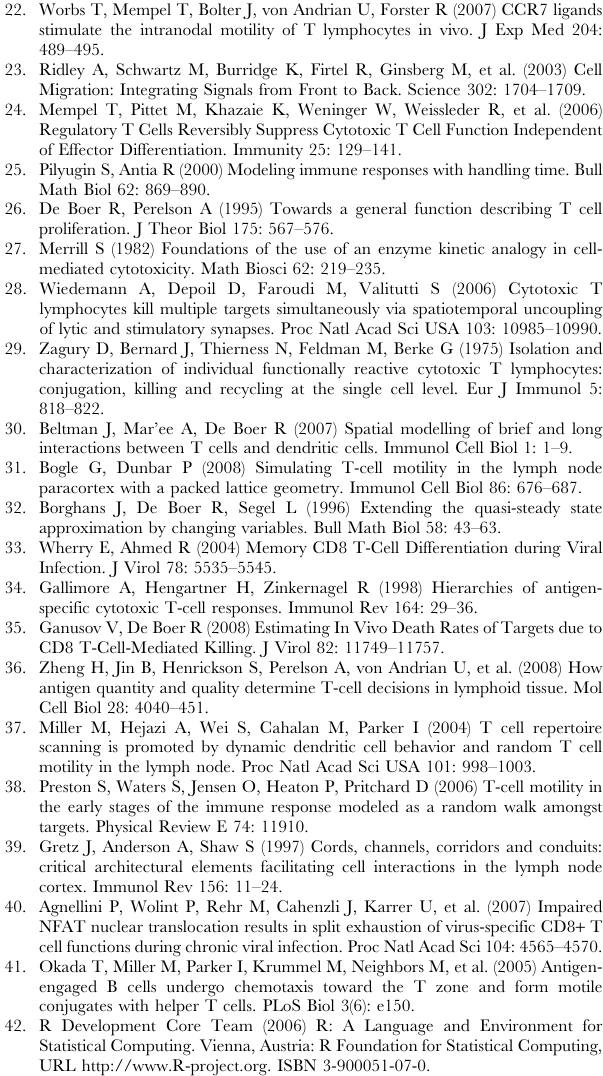
Figure S4 Estimates for k given different probabilities of recognition of CTL for targets. The killing duration and the CTL velocity were kept constant ( v h , 10.8 m m/min, t D = 15 min). Each dot represents the estimate for one simulation follwed over a time period of 300 min using the revised estimation method based on the proportion of target cells killed. Blue squares represent the mean values per probability of recognition. Found at: doi:10.1371/journal.pcbi.1000466.s004 (0.11 MB TIF) Video S1 Movement of simulated CTL in the absence of killing. A time period of 60 min is shown. The CTL velocity is set to v h = 10.8 m m/min. MPG) Video S2 Dynamics for the interaction of CTL (blue) and target cells (red) for one simulation. Ths simulation was parameterized with v h = 10.8 m m/min and t D = 15 min. CTL and target cells